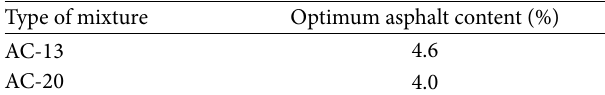
Figure 9: Aggregate gradation. Table 11: Optimum asphalt